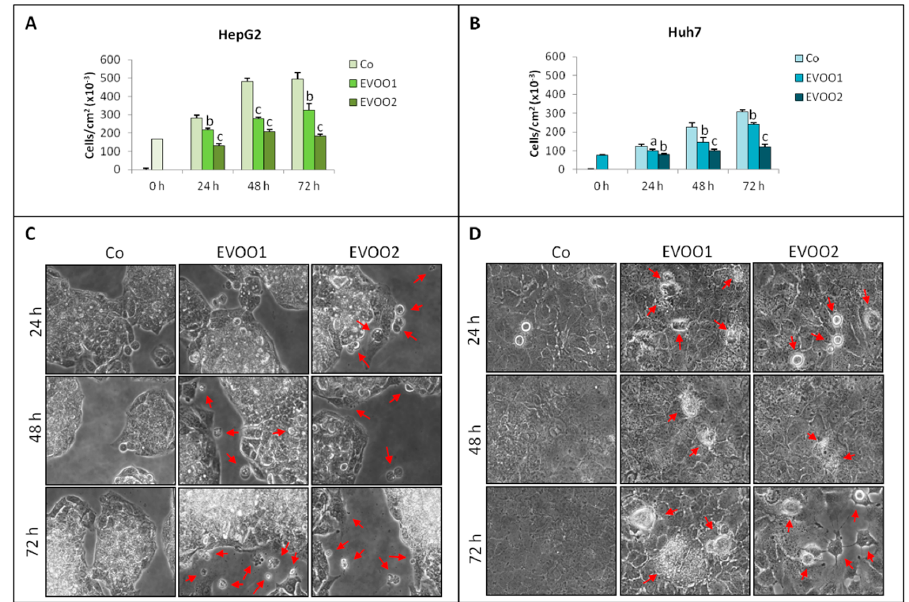
Figure 1. Phenolic extract reduces liver cancer cell proliferation. ( A , C ) Growth curve and morphological analysis on HepG2 cell line. ( B , D ) Growth curve and morphological analysis on Huh7 cell line. The cells were incubated for 24–72 h with two different doses of the extra-virgin olive oil (EVOO) extract. The results are representative of three experiments. Data are presented as mean ± standard deviation (SD). (a: p < 0.05, b: p < 0.01, c: < 0.001 versus Control). Red arrows indicate by apoptosis.